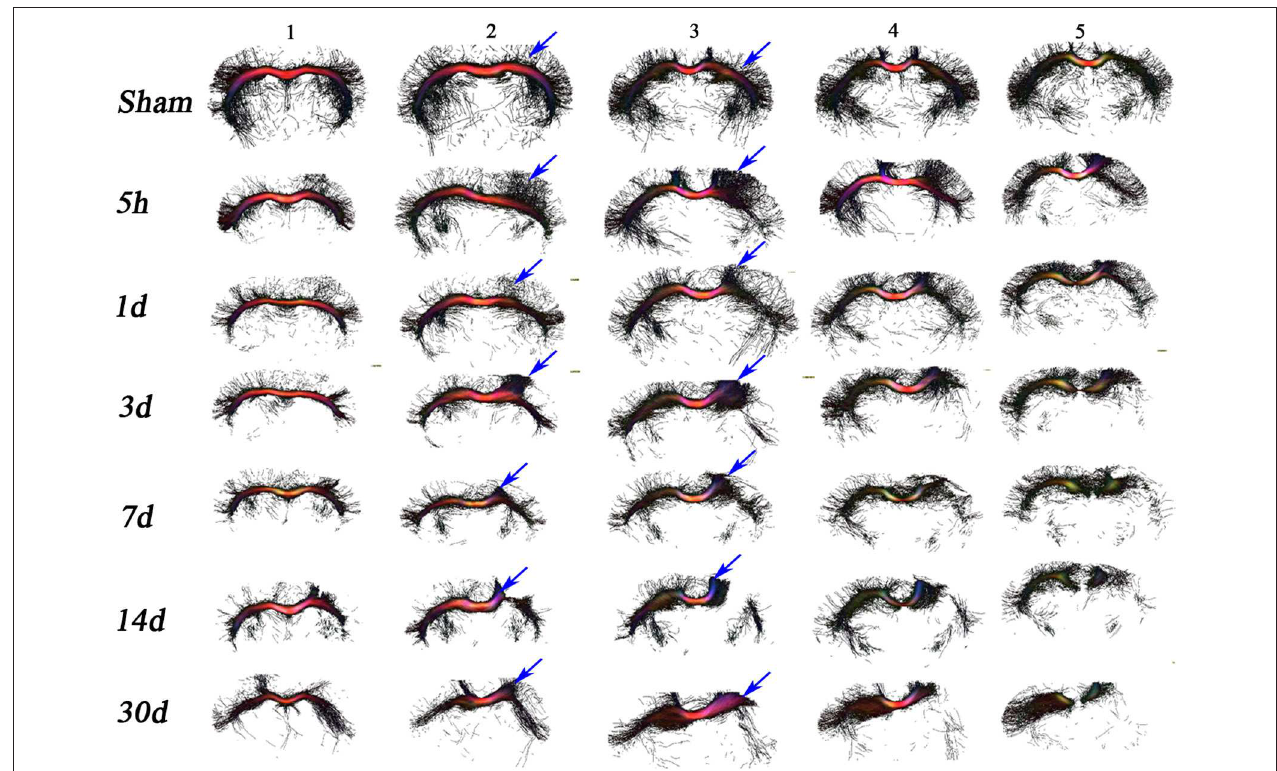
FIGURE 2 | In vivo DTI tractography. Images depicting fiber tracks for a representative mouse from the sham and TBI groups at each time point have been provided to help understand the changes in the structure and directionality of water diffusion in white matter. Seed masks for corpus callosum were applied to generate tracks demonstrating the origin of additional tracts from the center of the CC (corpus callosum) region toward cortex in the TBI groups vs. sham group. After day 3, 7, and 14 post injury, tracks in the ipsilateral region were almost gone, loss of tracks was visible in the contralateral side as well. At day 30 similar loss of tracks on the ipsilateral and contralateral was